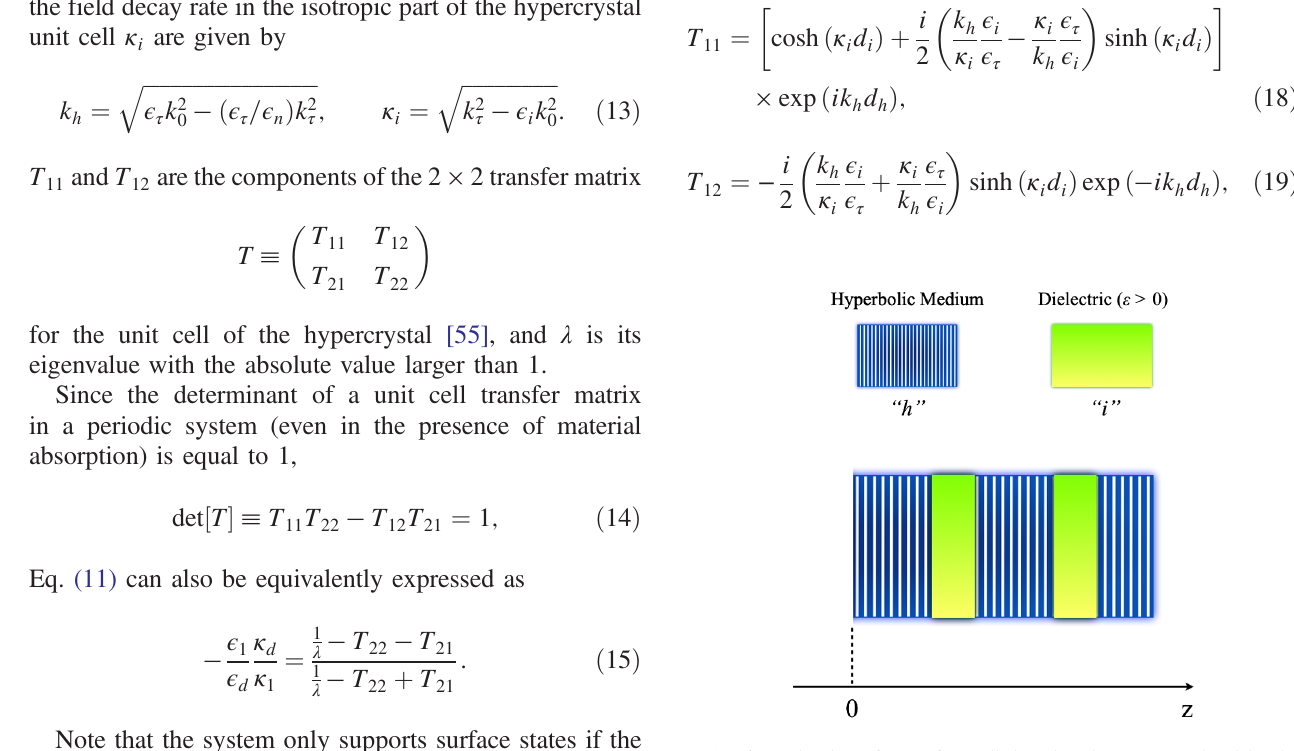
FIG. 6. The interface of a “ dielectric ” hypercrystal with air, with the former “ terminated ” at the hyperbolic layer. The letters in quotation marks represent the subscripts used in Sec. III for the corresponding